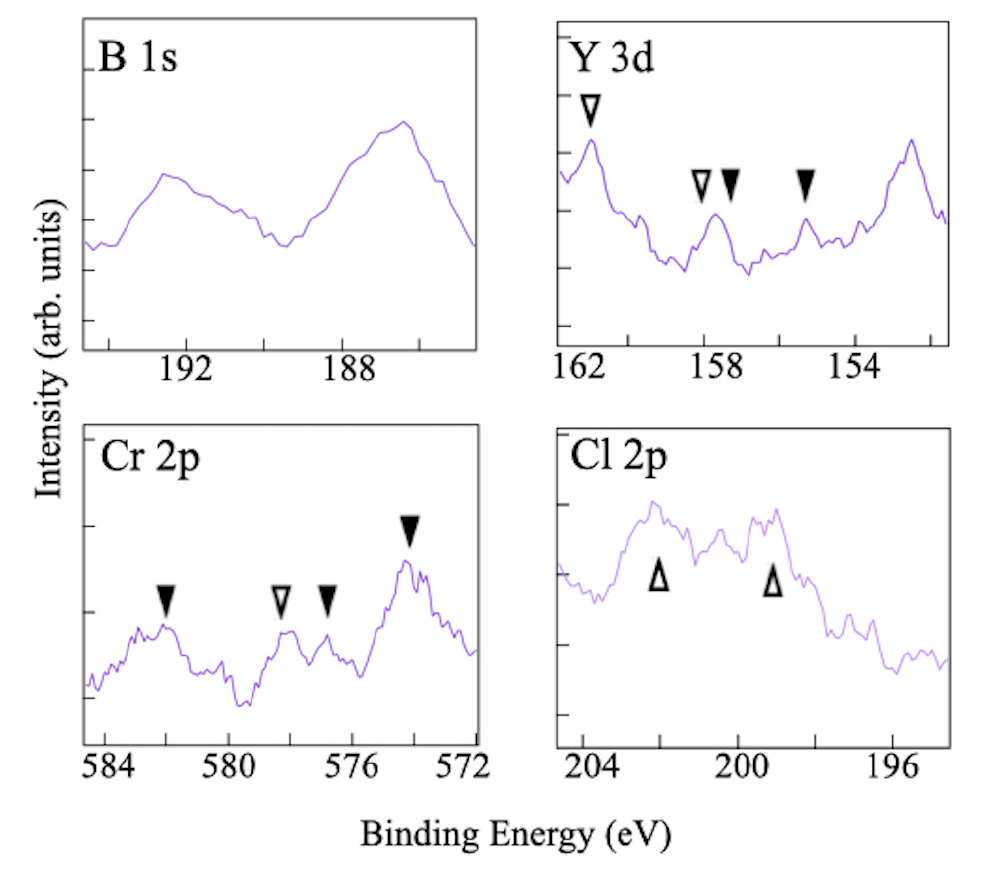
Figure 10. XPS spectra of the residue, taken after three days of reactions, for the core levels of B 1s, Y 3d, Cr 2p, and Cl 2p. Peaks of YCl 3 and CrCl 3 are labeled by open triangles [30,31], whereas remnants of YCrB 4 are labeled with black triangles